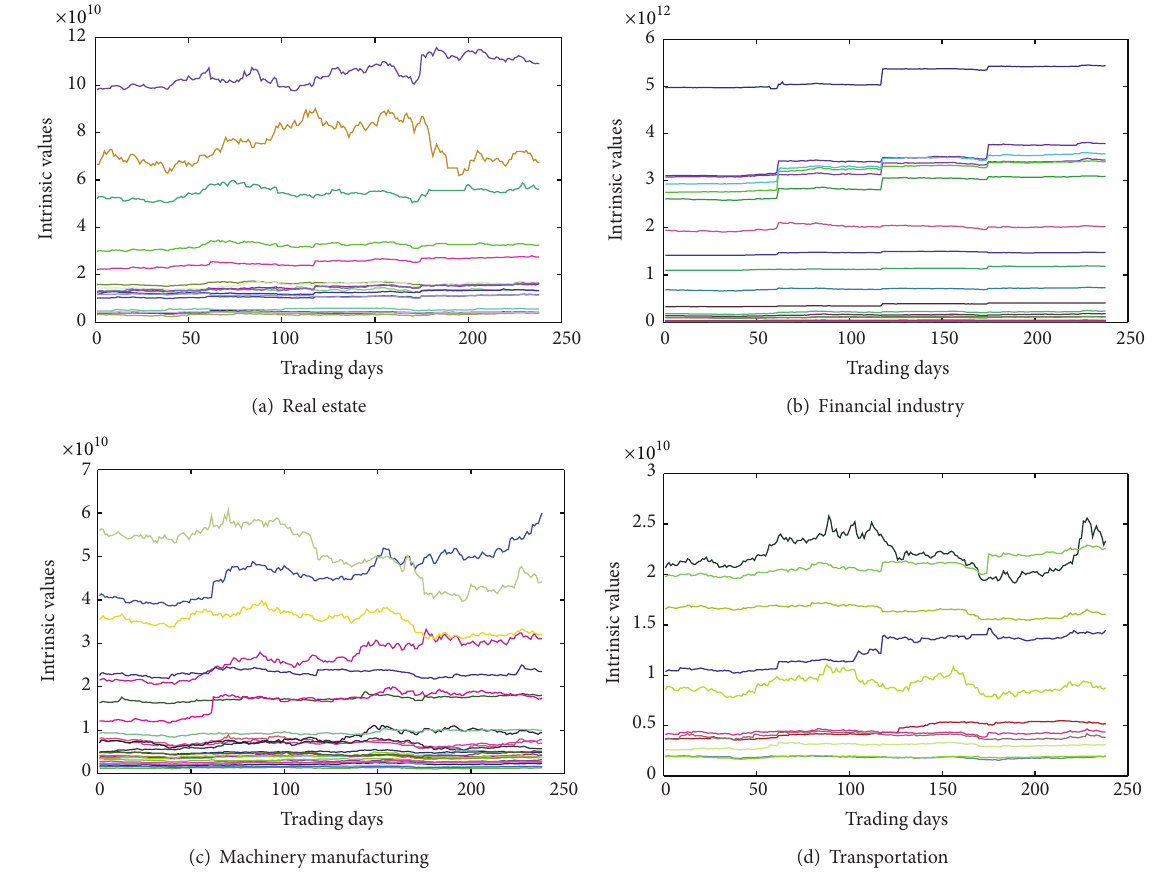
Figure 1: Paths for intrinsic values of